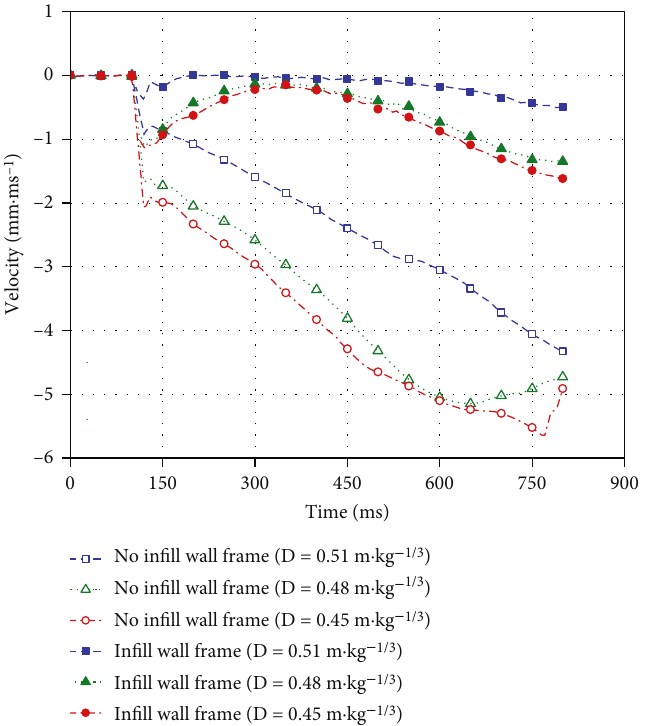
Figure 12: The z -direction velocity of the apex of the bottom column.